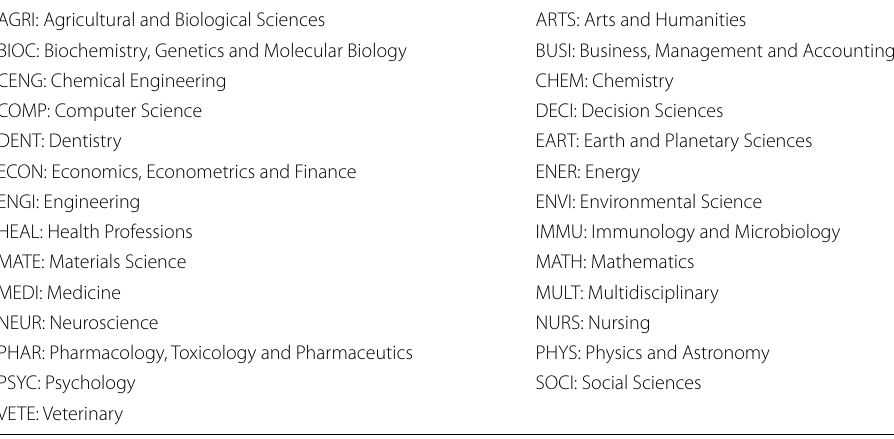
Table 3 Research